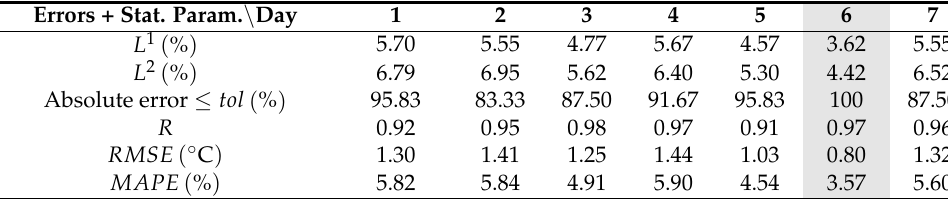
Table 12. Relative error CS1. Errors + Stat. Param. \ Day